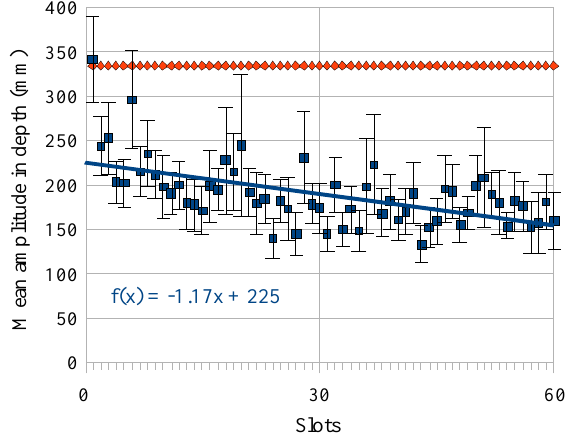
Figure 3. Mean amplitude of the vergence response (blue squares) as a function of the slot number. Blue line: regression line through the vergence amplitude data. Orange diamond: amplitude of the vergence demand as a function of the slot number. The error bars around the blue squares show the standard error of the mean vergence